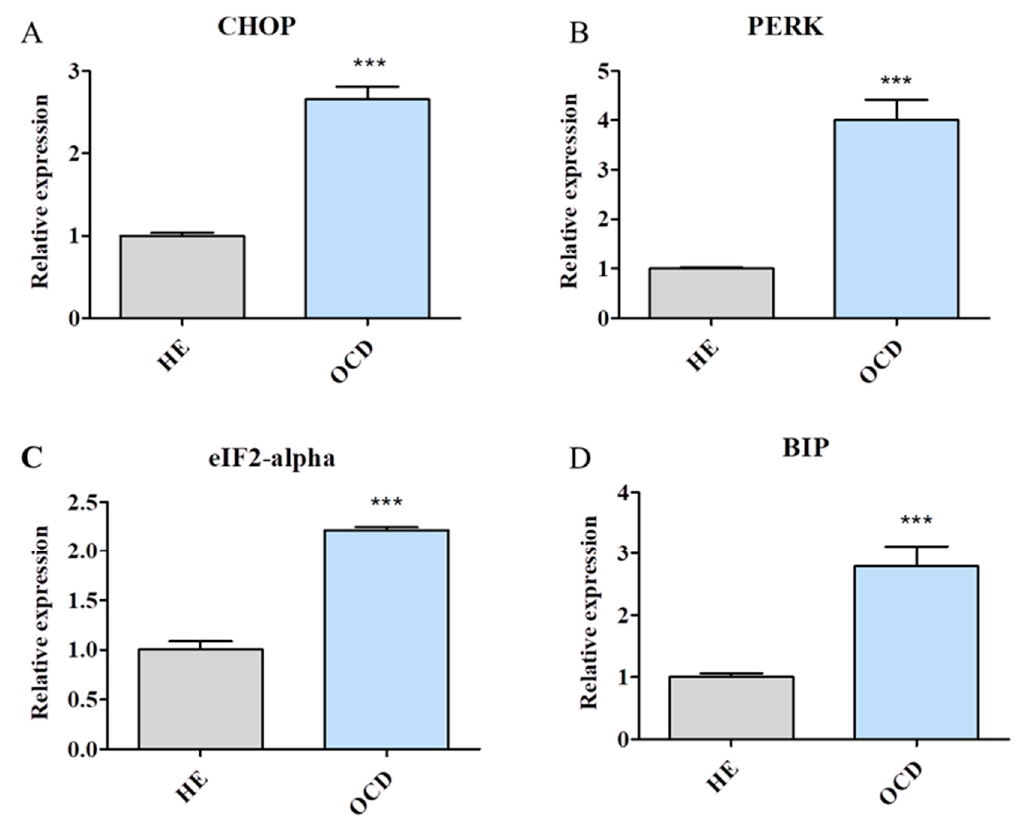
Figure 4. Expression of endoplasmic reticulum (ER)-stress related genes. In order to investigate whether OCD triggers ER stress in chondrocytes expression of CHOP ( A ), PERK ( B ), aIF2-aplha ( C ) and BIP ( D ) was investigated with RT-PCR. Results expressed as mean ± S.D. *** p < 0.001.